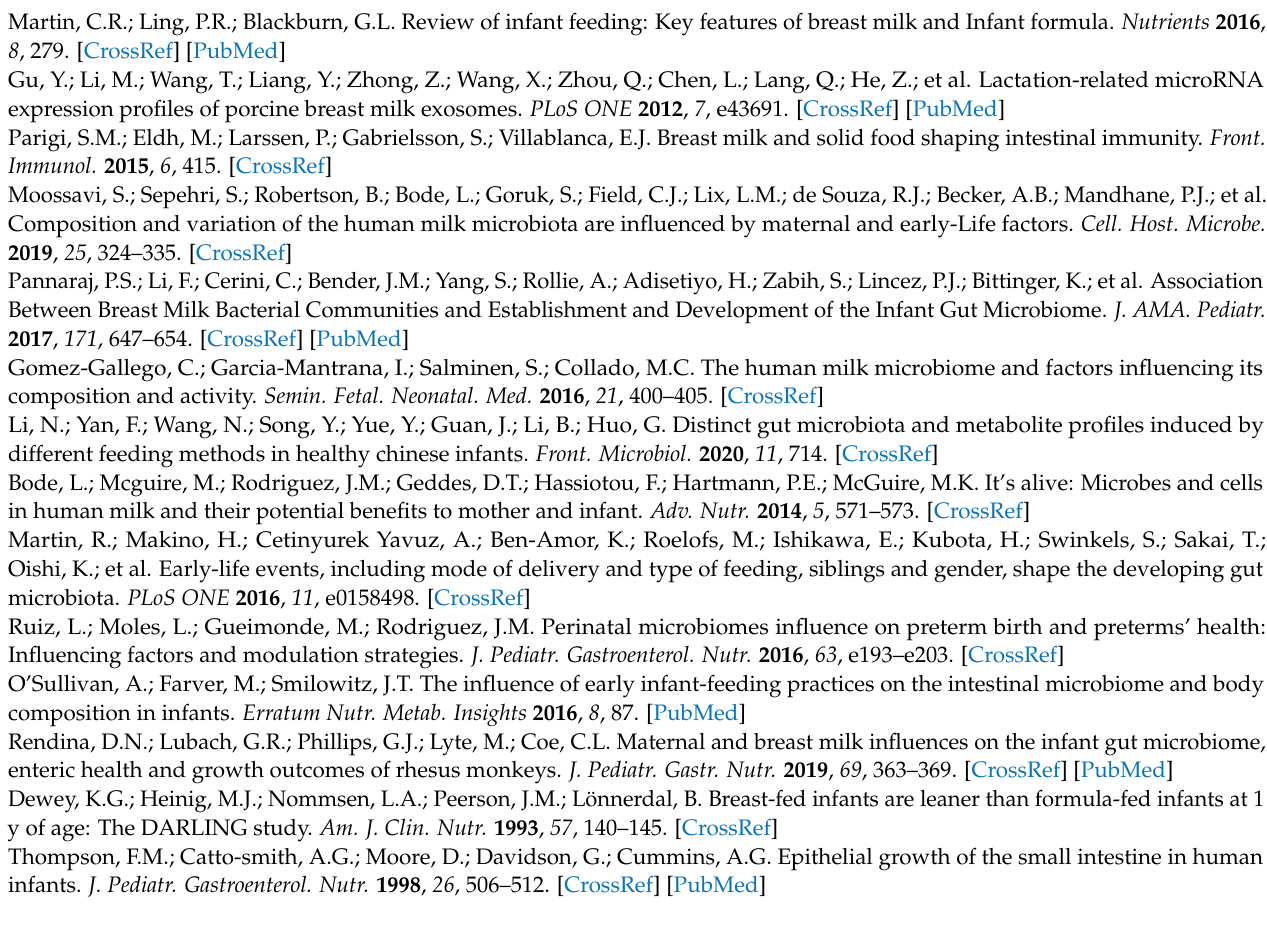
S1: Serum metabolism indicators; Figure S2: Evaluate the quality of sequencing data. (A) Species accumulation curve. (B) Rarefaction curve; Figure S3: Operational taxonomic unit (OUT) rank curve; Figure S4: Linear discriminant analysis (LDA) effect size (LEfSe). Only the logarithmic 2 < LDA score < 4 is shown for demonstration and